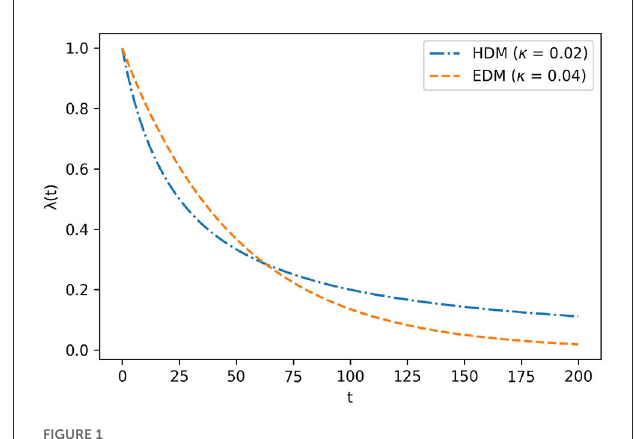
FIGURE1 Graph of EDM and